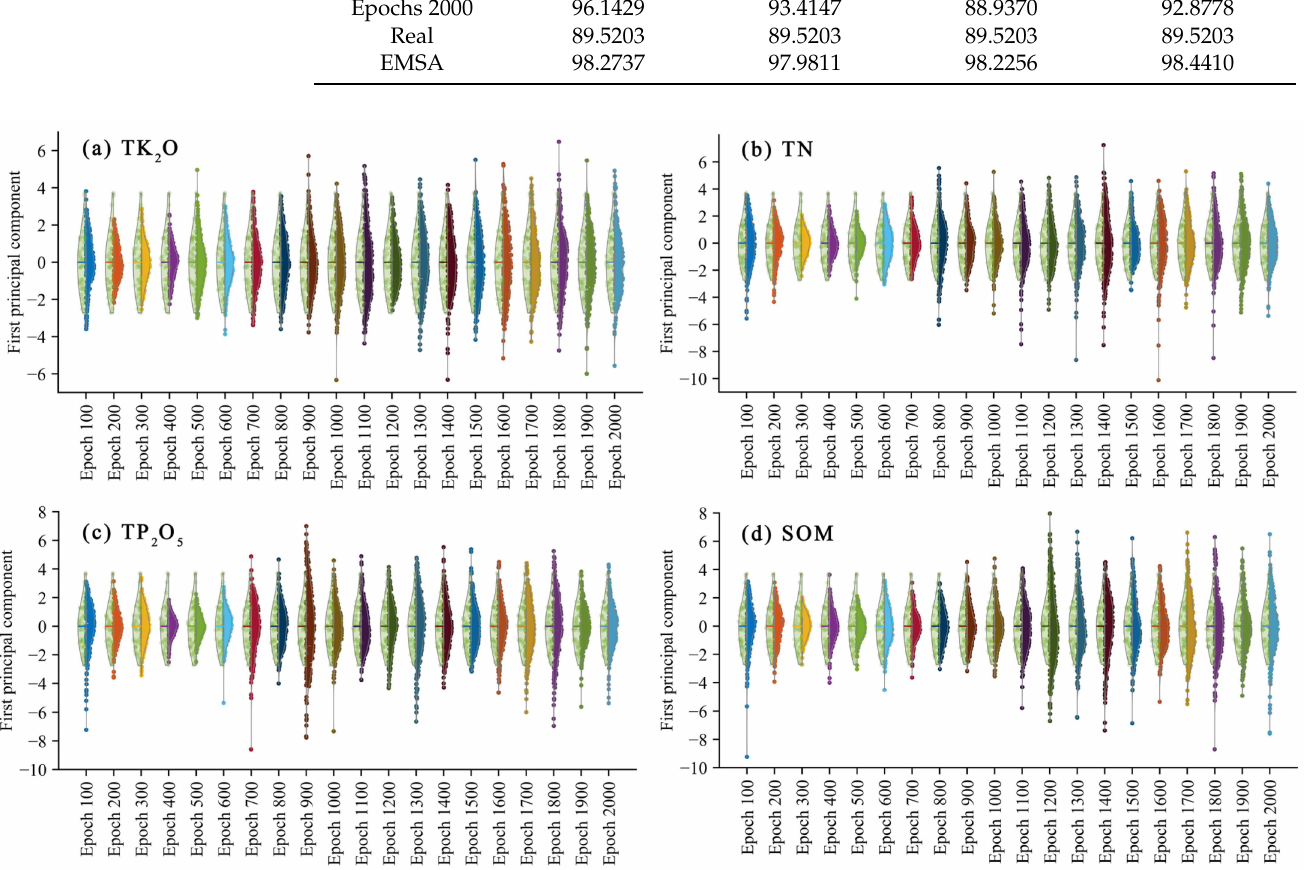
Figure 6. PCA analysis of GAN spectra and real spectra. The probability distribution of the reduced- dimensional data was plotted using split violins to compare the fake data with the real data. The real data are the left half of the violin, and the fake data are the right